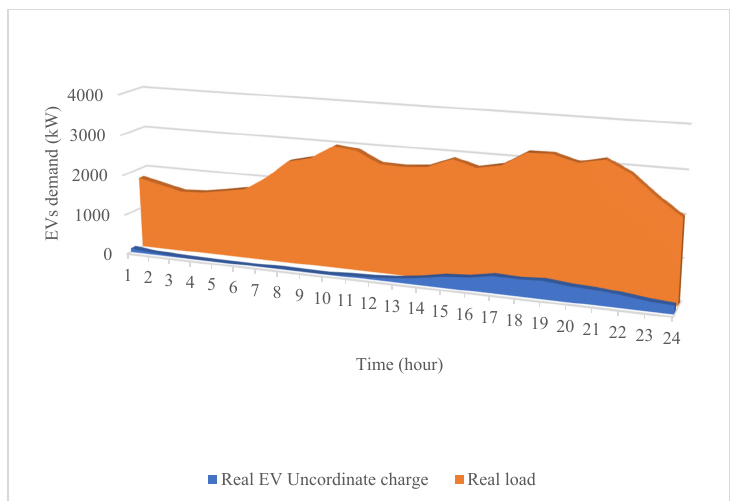
Figure 10. Impact of uncoordinated charging on the network load.